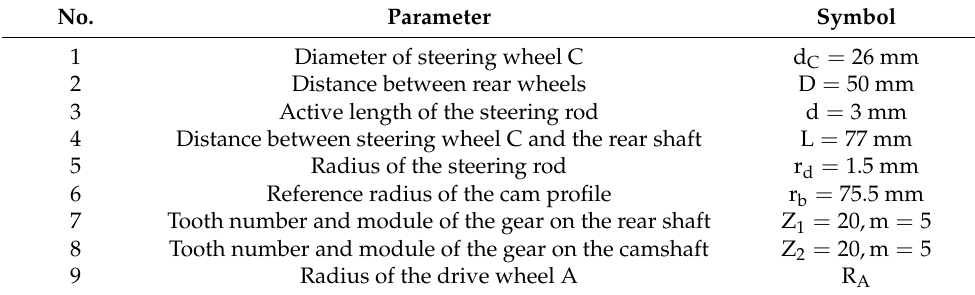
Figure 4. Test prototype. Table 2. Test values of